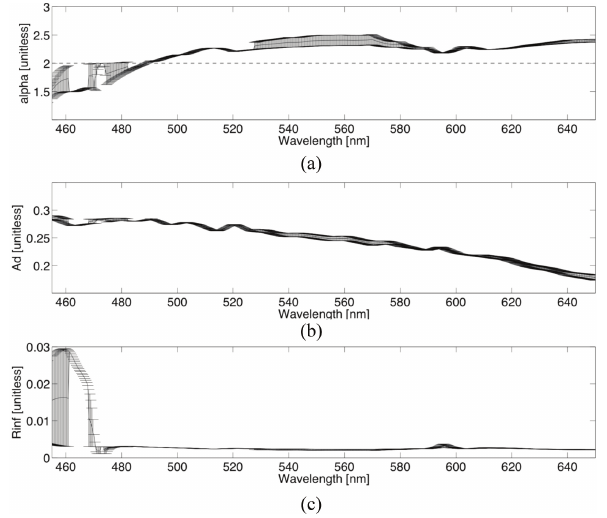
Fig. 4. Spectral dependency of α (top) and Ad (bottom) values de- rived from the minimization of the difference 1R between mea- sured and theoretical water-leaving reflectance values. Bars repre- sent the range of values when different 1R values are used (see text for details).